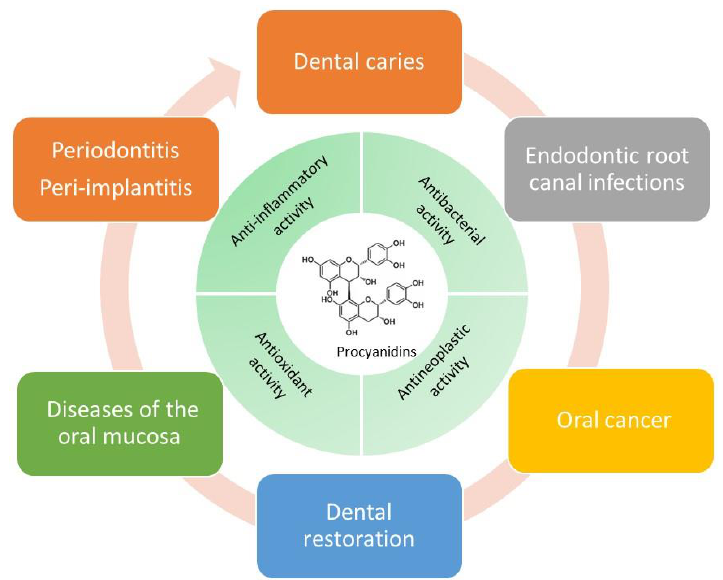
Figure 1. Structure, properties and therapeutic applications on oral diseases of procyanidins. Notes: Procyanidins, as an emerging pharmaceutical with multifunction, have versatile properties such as antioxidant activity, antibacterial activity, anti-inflammatory activity and antineoplastic activity. It has the capacity to therapy diverse oral diseases including oral cancer, periodontitis, dental caries, diseases of the oral mucosa, endodontic root canal; peri-implantitis and dental restoration.